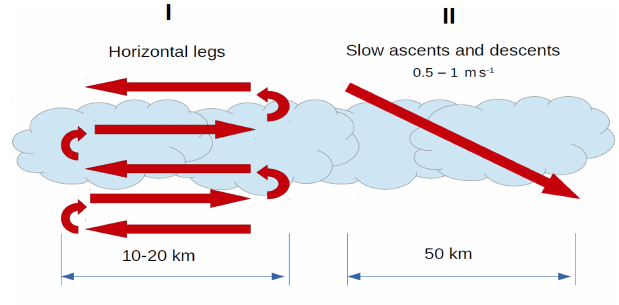
Figure 1. Flight pattern in clouds showing staggered horizontal legs and slanted profiles. Turns between legs were not included in the data analyses.